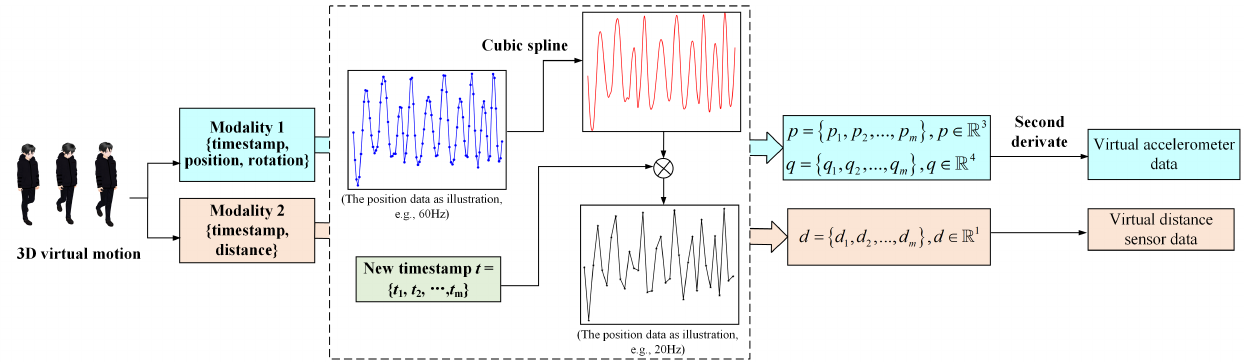
Figure 7. Virtual sensor implementation flow. The virtual data are taken together, along with time stamps. As the sampling time interval was not stable at this time, we exploited the cubic spline to reconstruct the continuous function between the time and the sampled signal value. Compared to the actual sensor system’s sampling characteristics, the virtual sampling frame rate can be adjusted by redividing the time domain with a new time interval. It therefore realizes arbitrary frame rate sampling and can correspond to the real